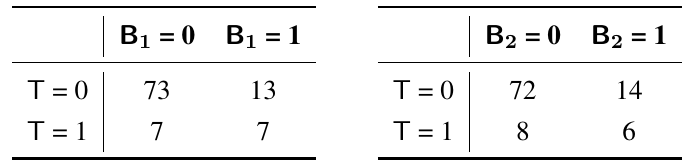
Table 2. Contingency tables of T and B RANKITMIX , respectively.